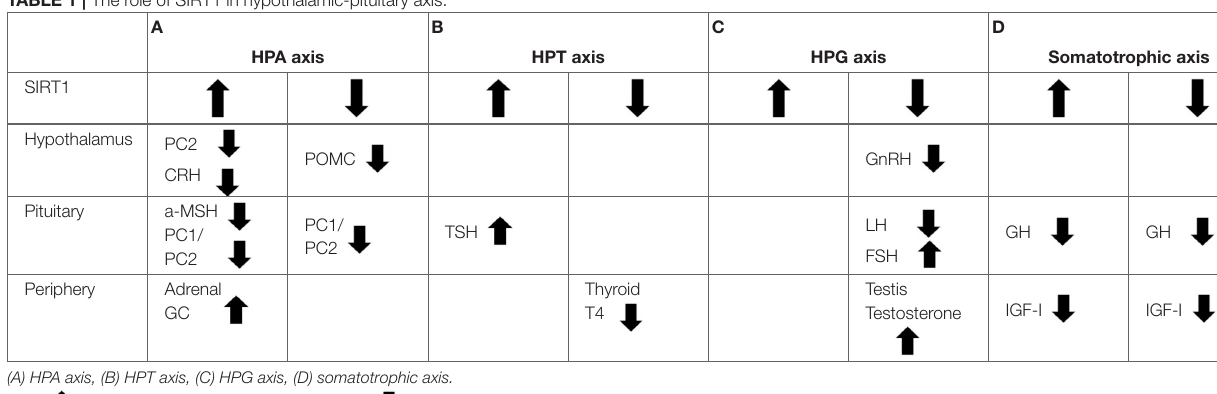
TABLE 1 | The role of SIRT1 in hypothalamic-pituitary axis. A B C D HPA axis HPT axis